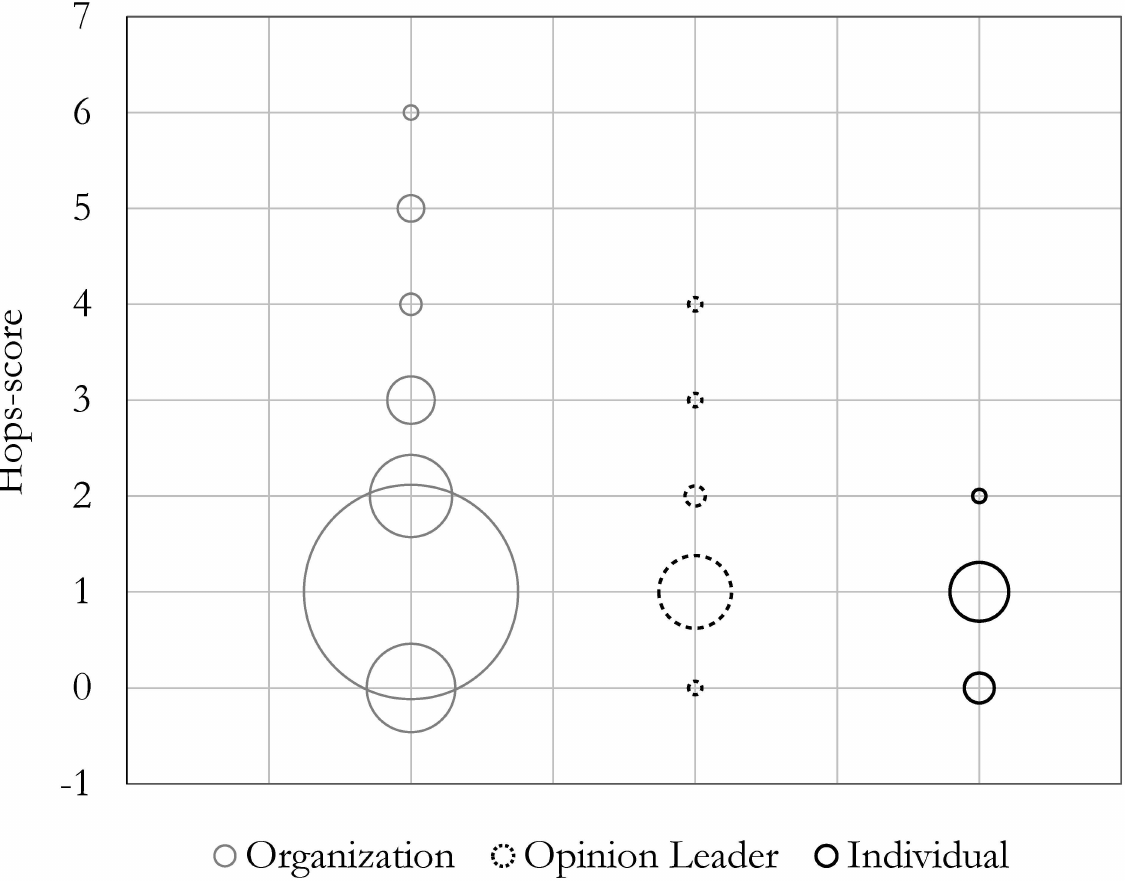
Fig 6. Hop-scores: Influence depth. Size of the circles indicate how frequent each score has been observed within an entity group of organization, opinionleader, or individual.